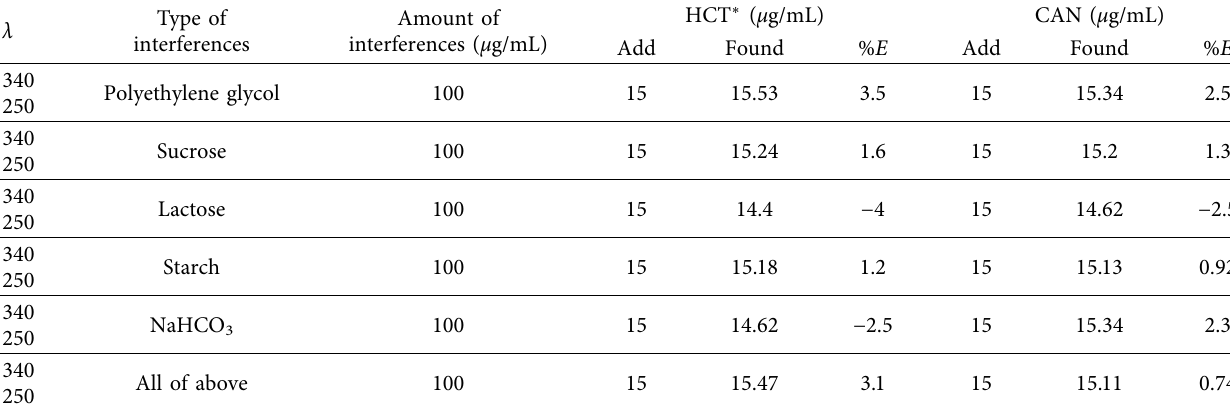
Table 15: Efect of interferences on the correction absorbance